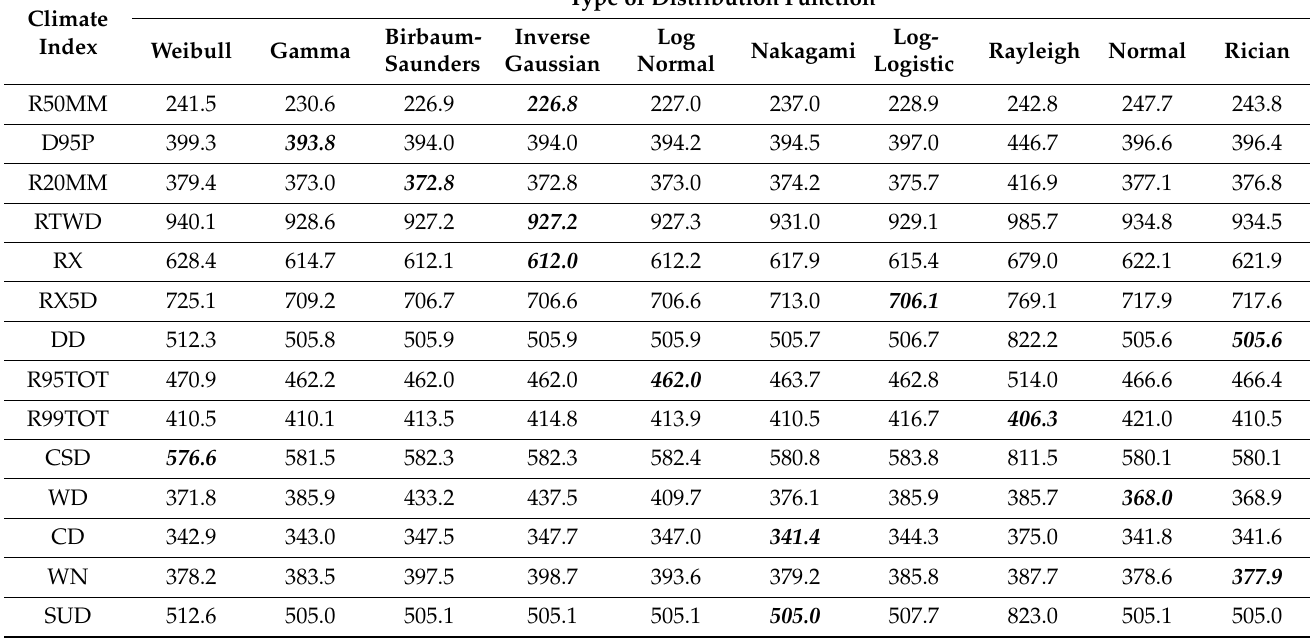
Table 3. BIC values and selection of distribution function of the Expert Team on Climate Change Detection and Indices